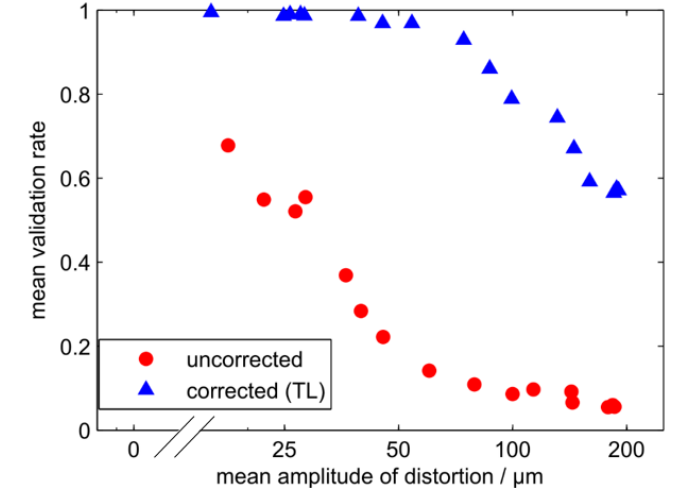
Figure 2. Mean validation rate with and without distortion correction by the tunable lens (TL) in dependence of the mean amplitude of the distortion, i.e. , height of the surface water